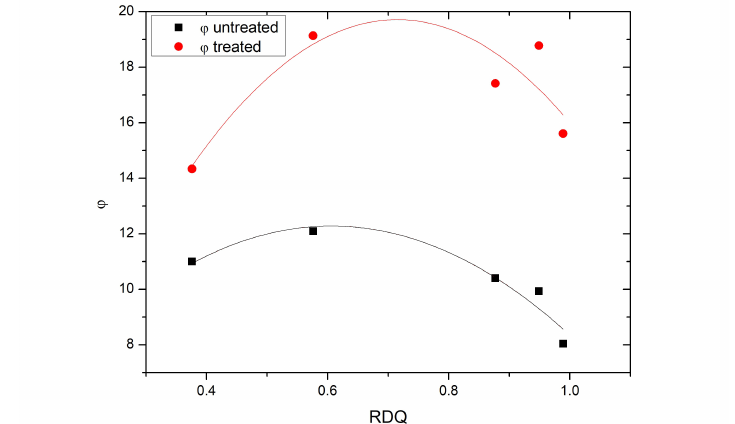
Figure 11. Shape factors, f, calculated using Equation (1), as a function of